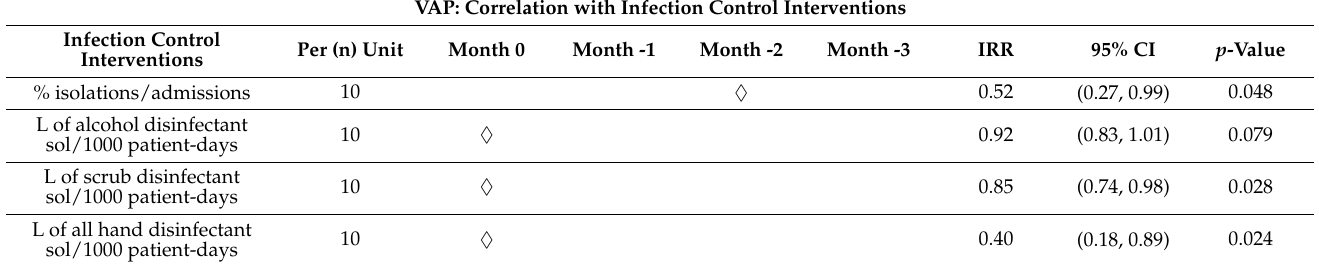
Table 6. Correlation of Incidence of VAP with infection control interventions in the ICU, January 2013 to December